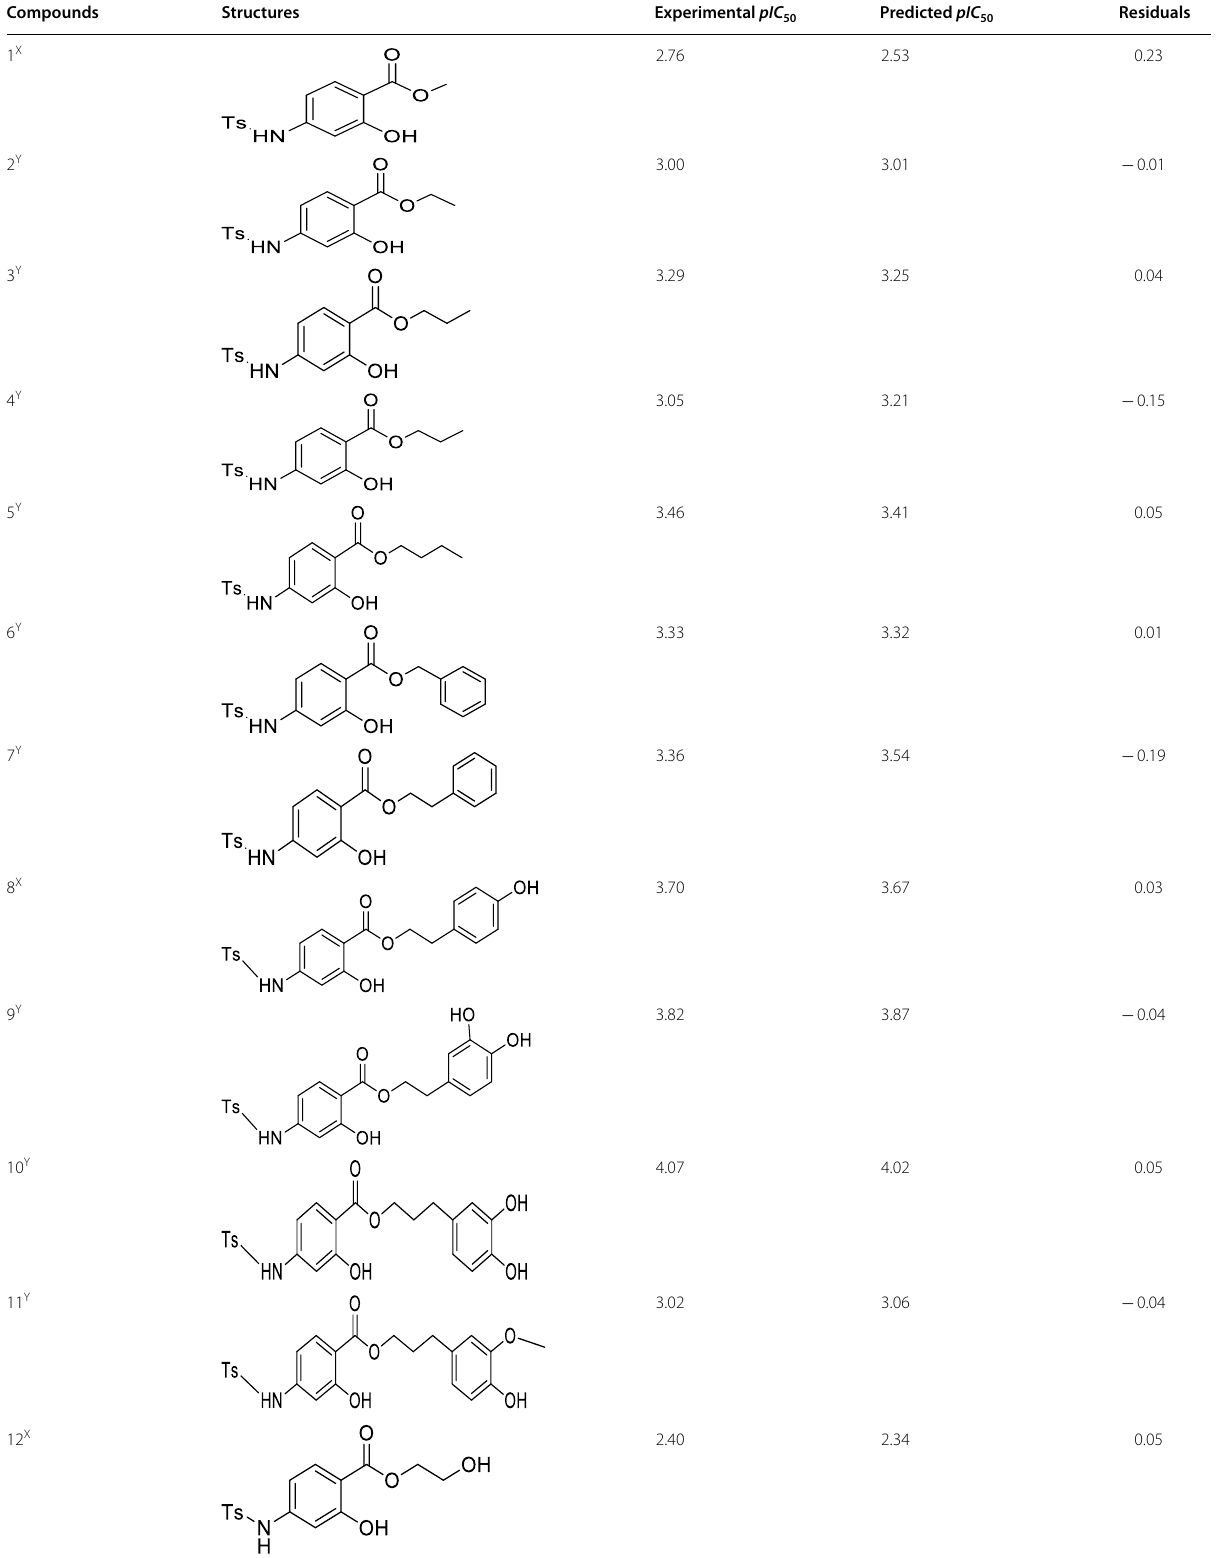
, predicted pIC 50